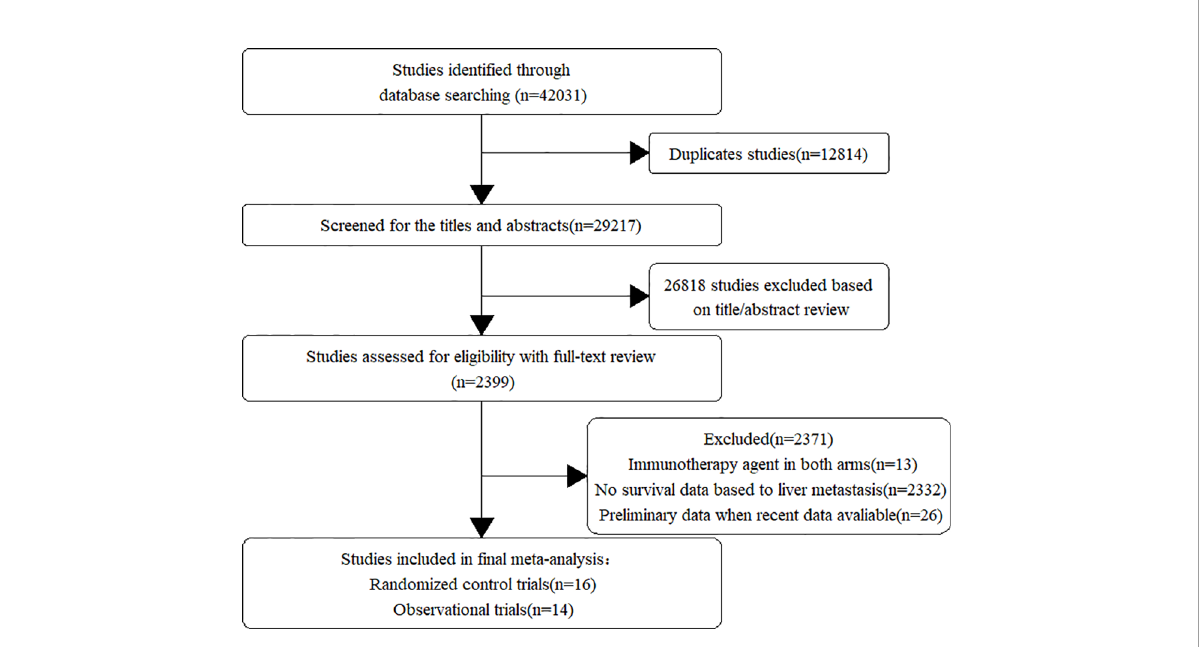
FIGURE 1 Flow chart of study selection and